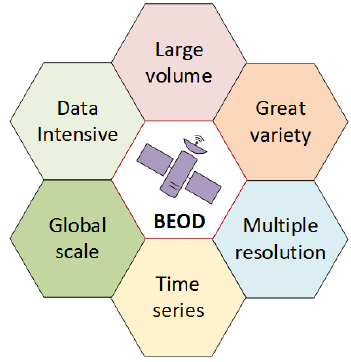
Figure 3. The characteristics of BEOD.